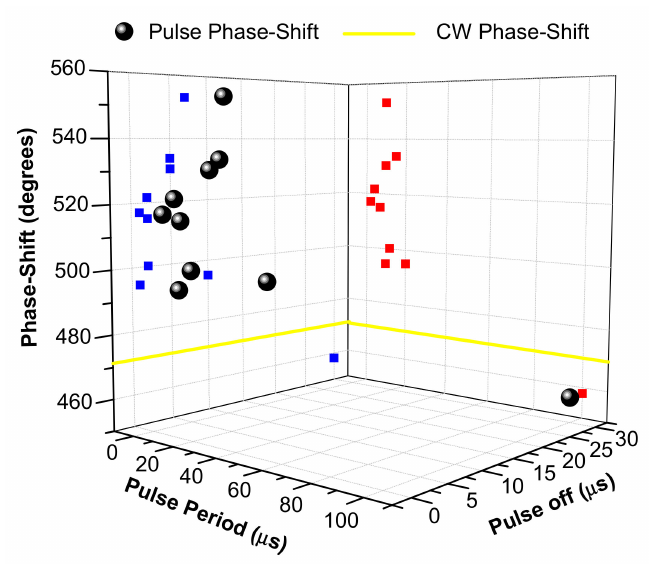
Figure 3. Polymer phase-shift after pulsed irradiation as a function of pulse period and pulse-o ff time ( • ), projection of the phase-shift in the pulse period axis ( (cid:4) ) and pulse-o ff time axis ( (cid:4) ). Polymer phase-shift after continuous irradiation